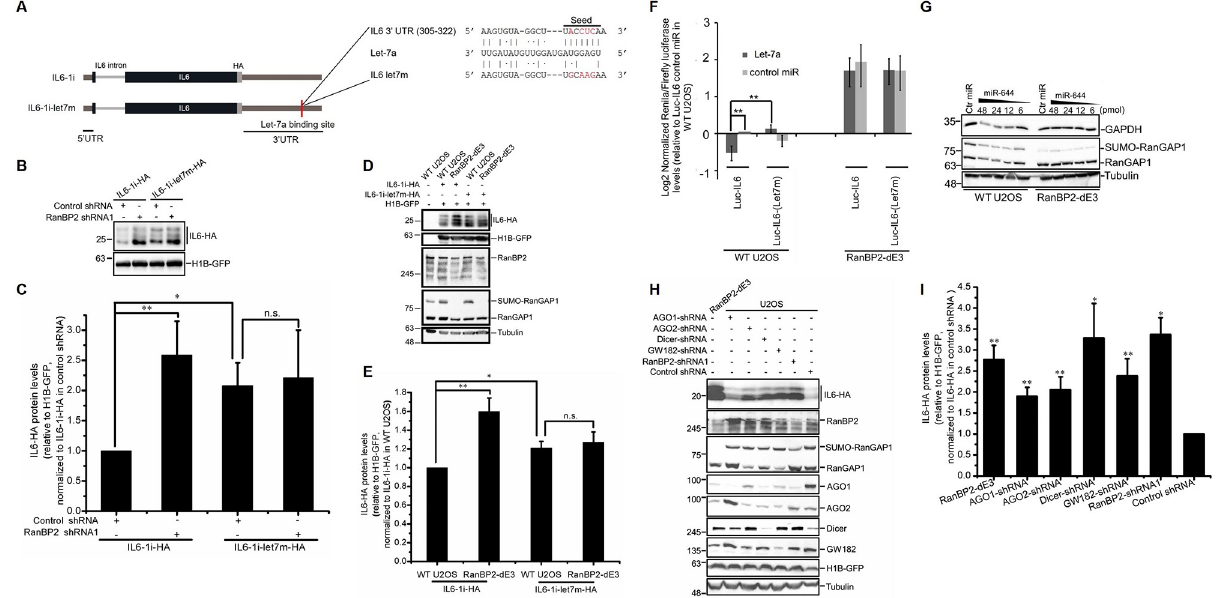
Fig 5. RanBP2 silences IL6 mRNA through its Let7 -binding site. (A) Schematic of the intron-containing IL6-HA construct ( IL6-1i ), without or with a mutation that eliminated the let-7 miRNA binding site ( IL6-1i-let7m ). (B-C) U2OS cells treated with lentivirus that delivered shRNA1 against RanBP2, or scrambled shRNA (“control shRNA”) were co-transfected with the IL6-1i constructs in (A) and histone 1B-GFP ( H1B-GFP ). 24 h post-transfection, cell lysates were collected and separated by SDS-PAGE. The level of IL6-HA and GFP were analyzed by immunoblot (B). The IL6-HA/H1B-GFP ratio was quantified using densitometry analysis, normalized to IL6-1i-HA -transfected control shRNA-treated cells, and plotted (C). (D-E) Unmodified and RanBP2-dE3 U2OS cells were transfected with IL6-1i-HA or IL6-1i-Let7m-HA and H1B-GFP . Cell lysates were collected 24 h post-transfection and separated by SDS-PAGE. Proteins were detected with by immunoblot with antibodies against HA, GFP, RanBP2, RanGAP1 and α -tubulin (D). IL6-HA and H1B-GFP protein levels were quantified using densitometry analysis and the ratio of IL6-HA/H1B-GFP was normalized to IL6-1i-HA transfected unmodified U2OS cells (E). (F) Unmodified and RanBP2-dE3 U2OS cells were co-transfected with Let7a miRNA or a scrambled control miRNA (“control miR”), and a dual luciferase plasmid that contains a Renilla luciferase reporter plasmid, carrying either the wild-type 3 0 UTR of IL6 ( Luc-IL6 ) or the Let7a binding site mutant ( Luc-IL6-(Let7m ), see Fig 5A for the sequence), and the Firefly luciferase as an internal control. 24 h after transfection, Renilla and Firefly luciferase luminescence were measured, and the ratio was normalized to unmodified U2OS cells transfected with Luc-IL6 and control miR. (G) Unmodified and RanBP2-dE3 U2OS cells were transfected with various amounts of miR-644 or 48 pmol of miR-144 (“Ctr miR”). 24 h post-transfection, cell lysates were collected, separated by SDS-PAGE, and immunoblotted for GAPDH, RanGAP1 and α -tubulin. (H-I) Unmodified U2OS cells were treated with lentivirus that delivered shRNAs against various proteins, or scrambled shRNA (“control shRNA”), and were transfected with plasmid containing the IL6-1i-HA construct. For comparison, RanBP2-dE3 U2OS cells were also included in this analysis. Cell lysates were collected 24 h post-transfection and separated by SDS-PAGE. Proteins were detected by immunoblot with antibodies against HA, RanBP2, RanGAP1, AGO1, AGO2, Dicer, GW182, GFP and α -tubulin (H). IL6-HA and H1B-GFP protein levels were quantified using densitometry analysis and the ratio of IL6-HA/H1B-GFP was normalized to IL6-1i-HA transfected unmodified U2OS cells (I). Each bar is the average of three independent experiments ± SEM. � P = 0.01–0.05, �� P = 0.001–0.01, n.s. indicates no significant difference (Student’s t